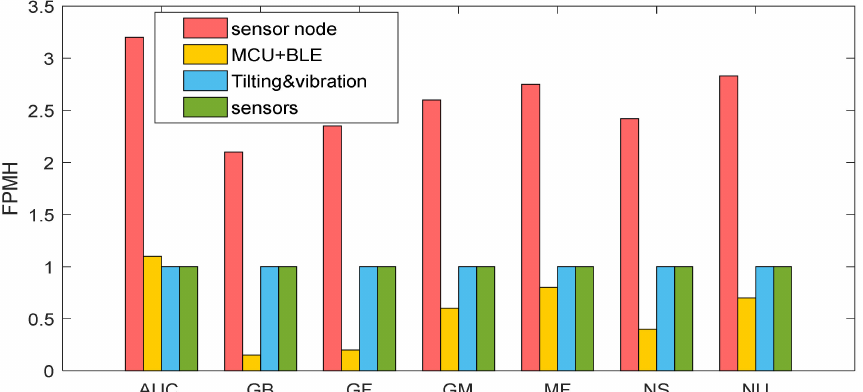
Figure 8. Expected number of failures for each individual subsystem (module) composing the sensor node in ‘continuous’ mode and considering the working environments previously listed. Red bars: failure rates of the whole sensor node; orange bars: failure rates of the MCU + BLE module; blue bars: failure rates of tilting and vibrations module; green bars: failure rates of the sensors module.